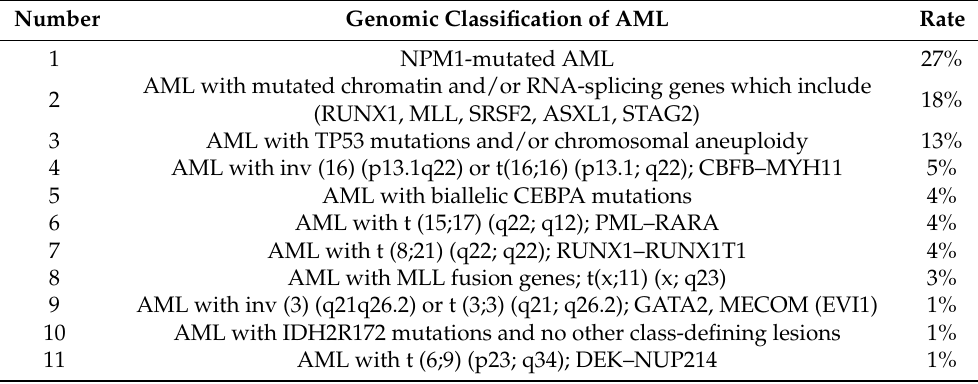
Table 1. WHO classification of AML subtypes